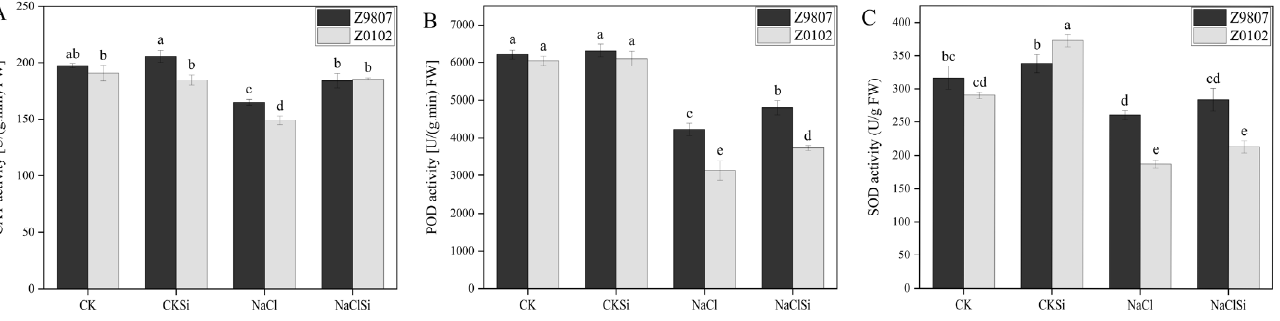
Figure 4. Effect of Si on the activity of CAT ( A ), POD ( B ), and SOD ( C ) under saline and non-saline conditions. Error bars represent the standard error ( n = 3). Different letters mean significantly different among treatments at p ≤ 0.05.